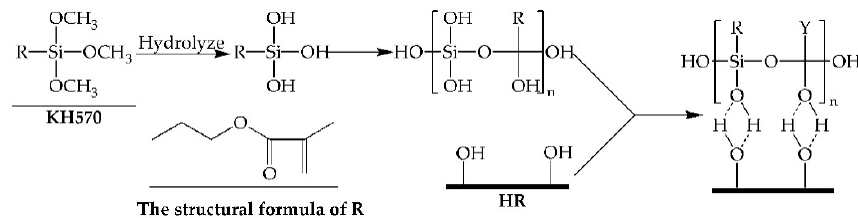
Figure 2. The reaction mechanism of HR and